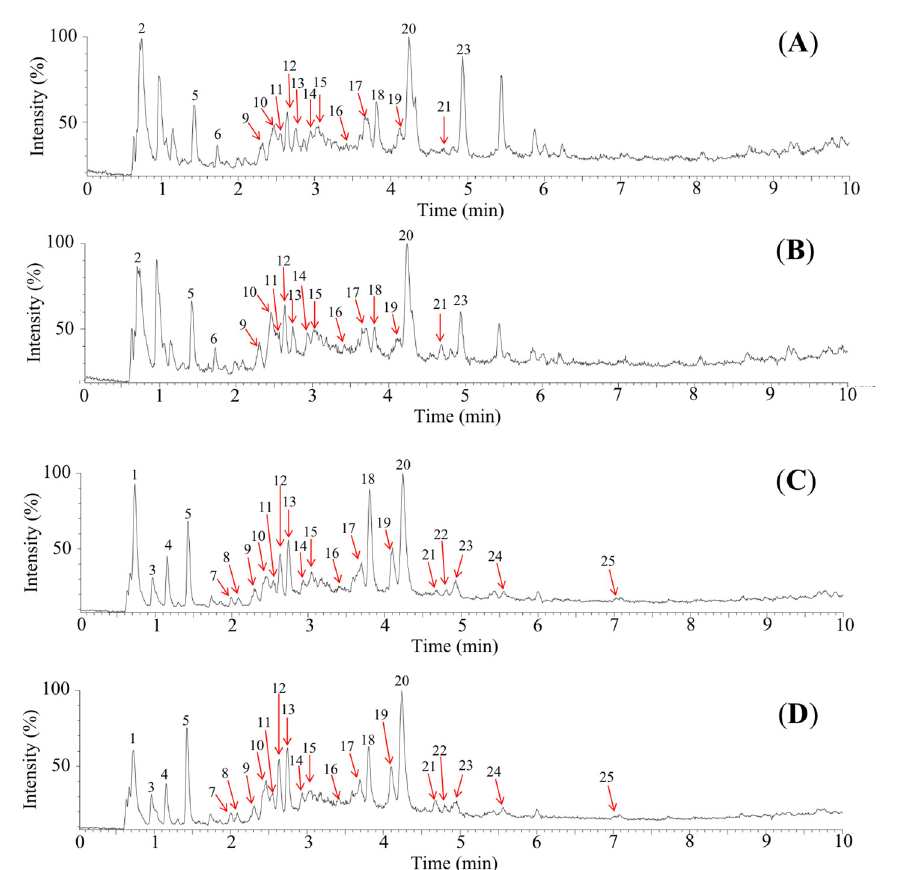
Figure 3. Total ion chromatography of 70% ethanol extracts from defatted seeds of Oenothera biennis (( A ) in positive mode, ( C ) in negative mode) and seeds of Oenothera biennis (( B ) in positive mode, ( D ) in negative mode).